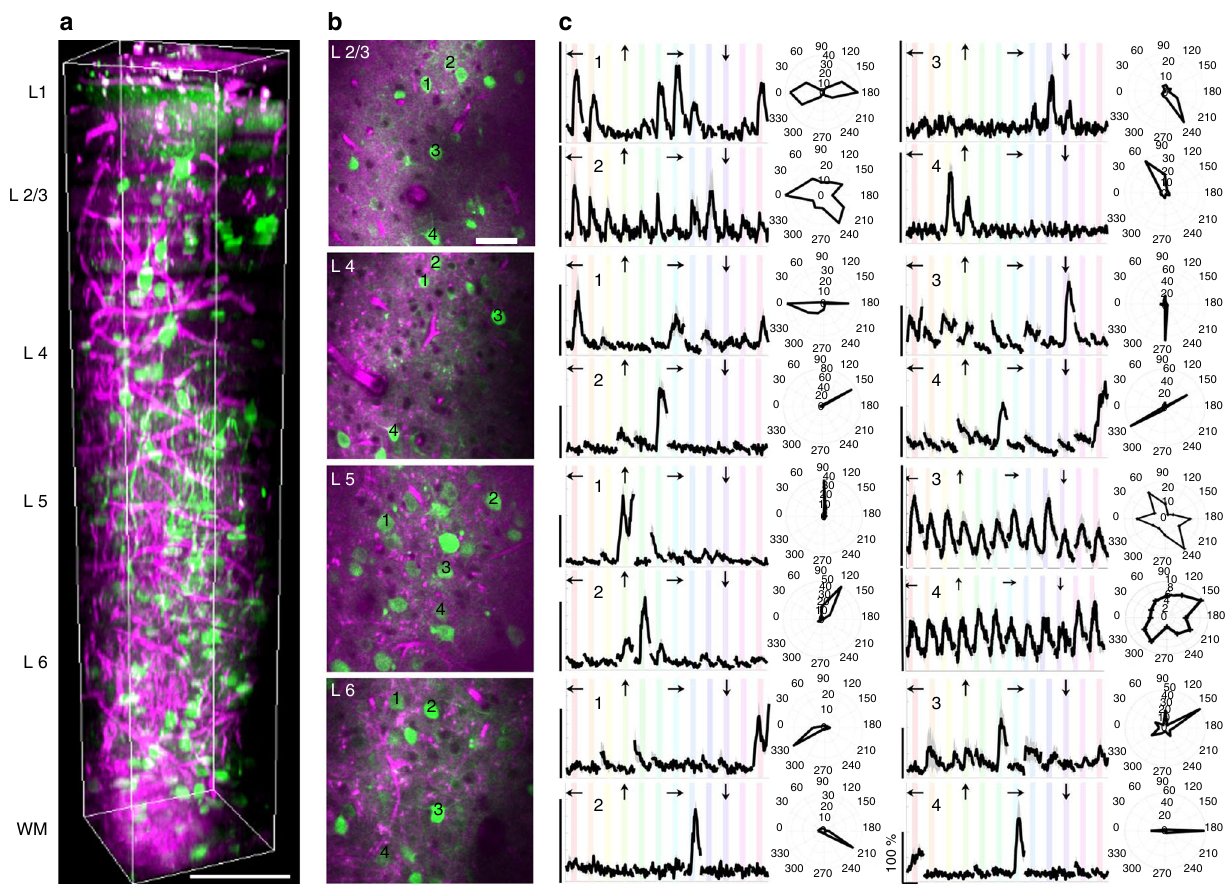
Fig. 3 Characterization of visual responses of different layers in V1 of awake mice. a Three-dimensional rendering of a sequence of 450 lateral three-photon images acquired with 2- µ m increment. Green color represents GCaMP6s signal, and magenta color represents label-free THG signal generated in the blood vessels in the visual cortex and myelin fi bers in the white matter. Scale bar, 100 µ m. b Selection of lateral images from layer 2/3, 4, 5, and 6. Scale bar, 50 µ m. Field of view in all lateral images is 250 μ m. c Average calcium responses ( Δ F / F ) for representative cells in each layer over 10 trials in response to oriented gratings moving in speci fi c directions (arrows above each trace) and their orientation tuning curves in polar plots. Discontinuities in ( Δ F/F) traces are due to the randomization of each stimulus direction in each trial. ( Δ F/F) scale bars correspond to 100% and time scale bar corresponds to 10 s as shown in the bottom right